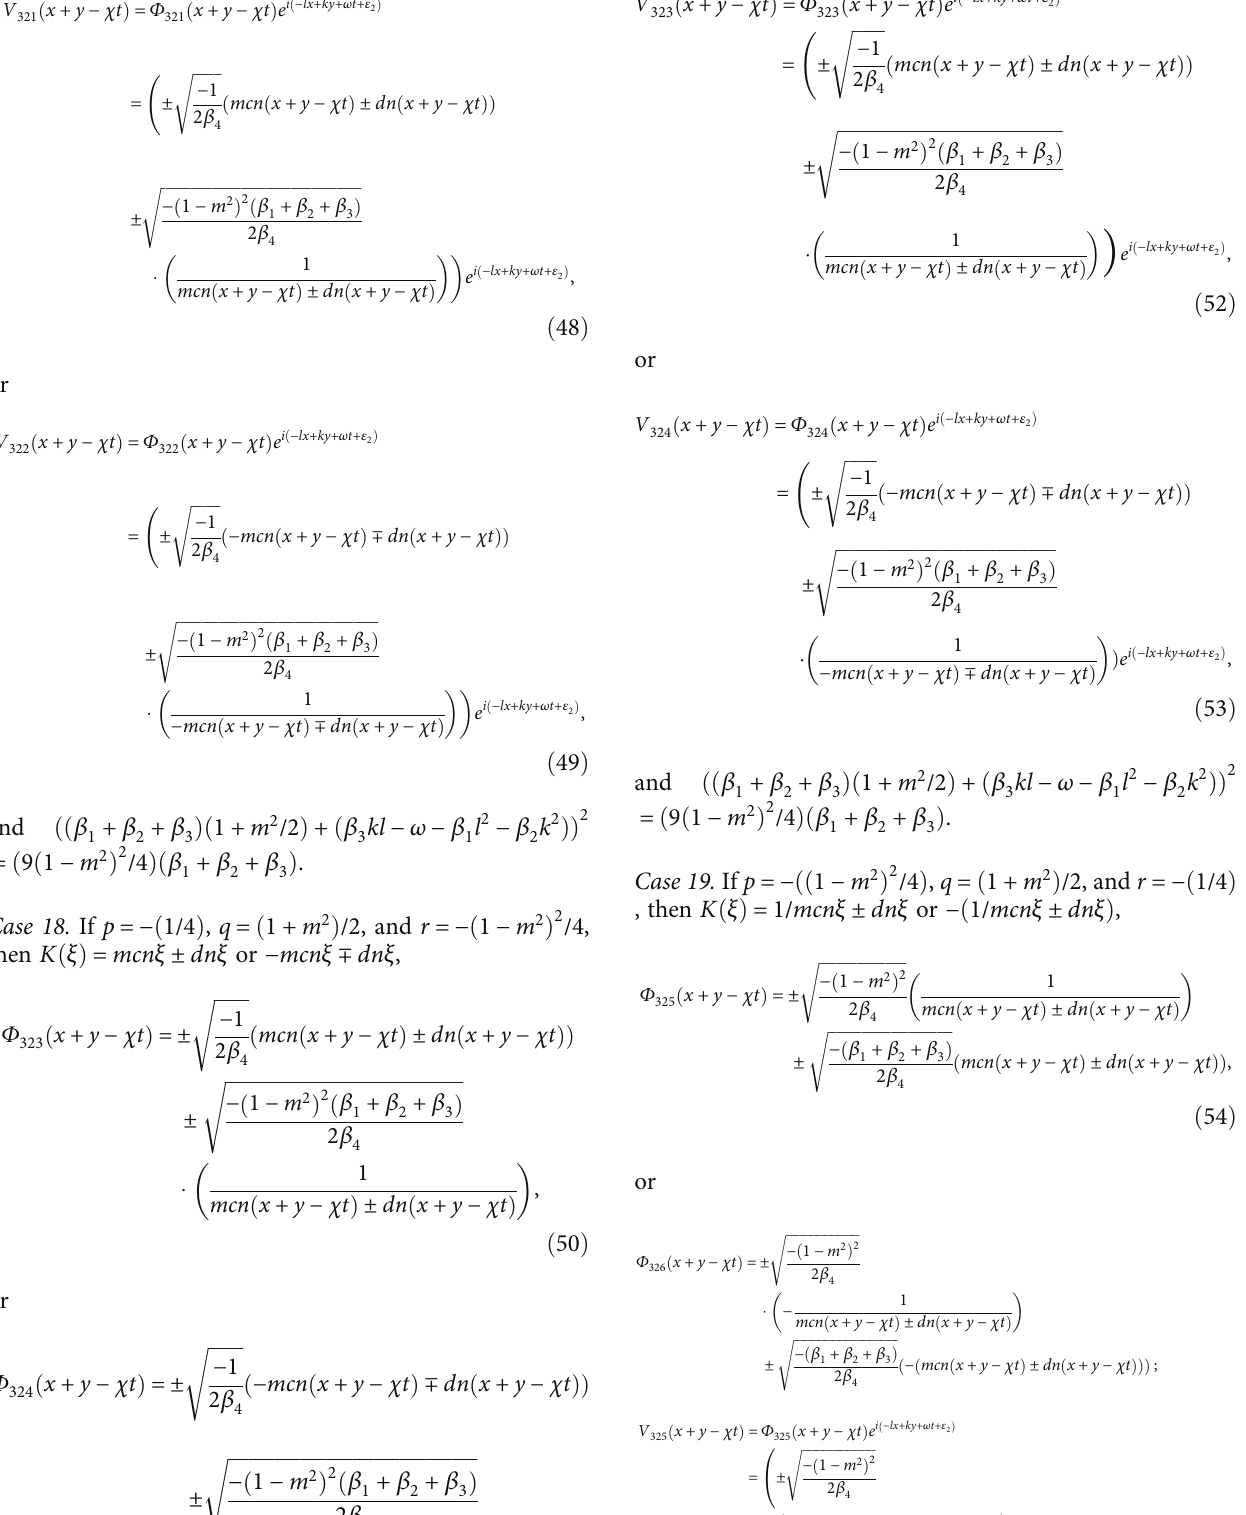
ffiffiffiffiffiffiffiffiffiffiffiffiffiffiffiffiffiffiffiffiffi − 1 − m 2 ð